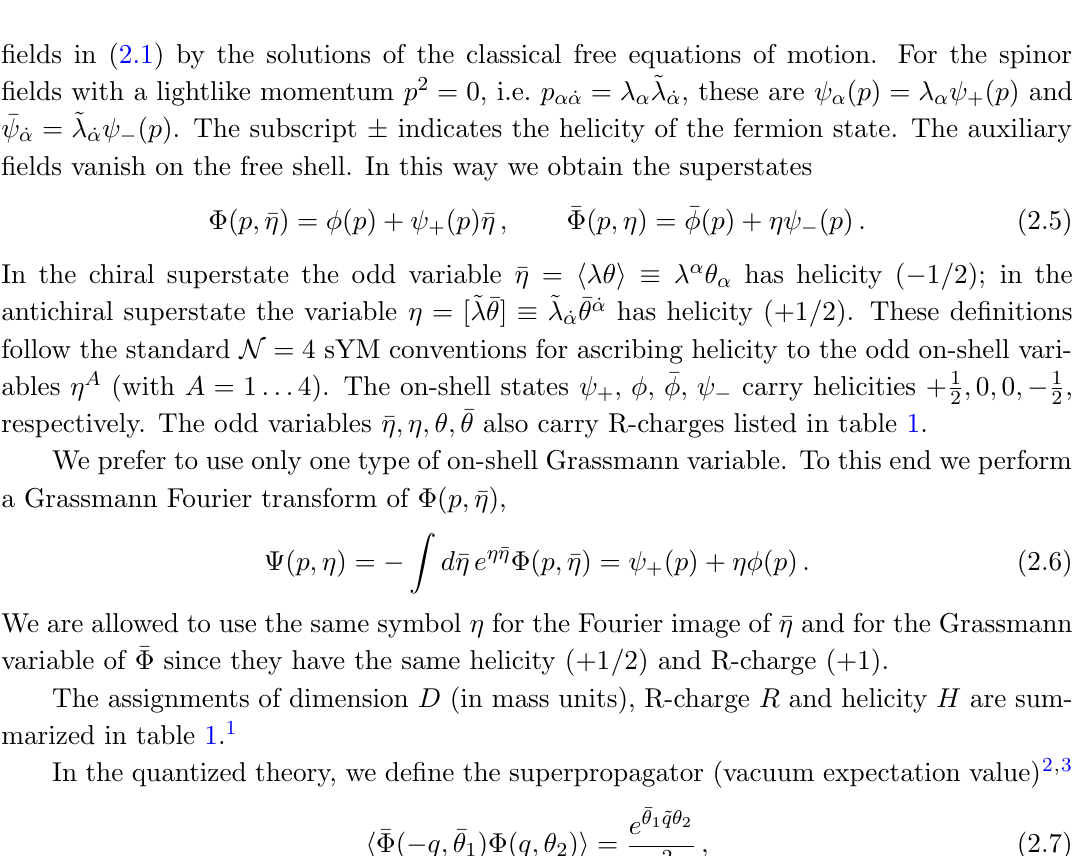
Table 1 . Quantum numbers of the variables and